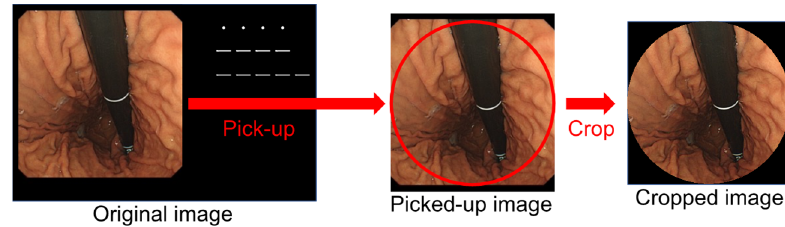
Figure 2. Image cropping for regularization.